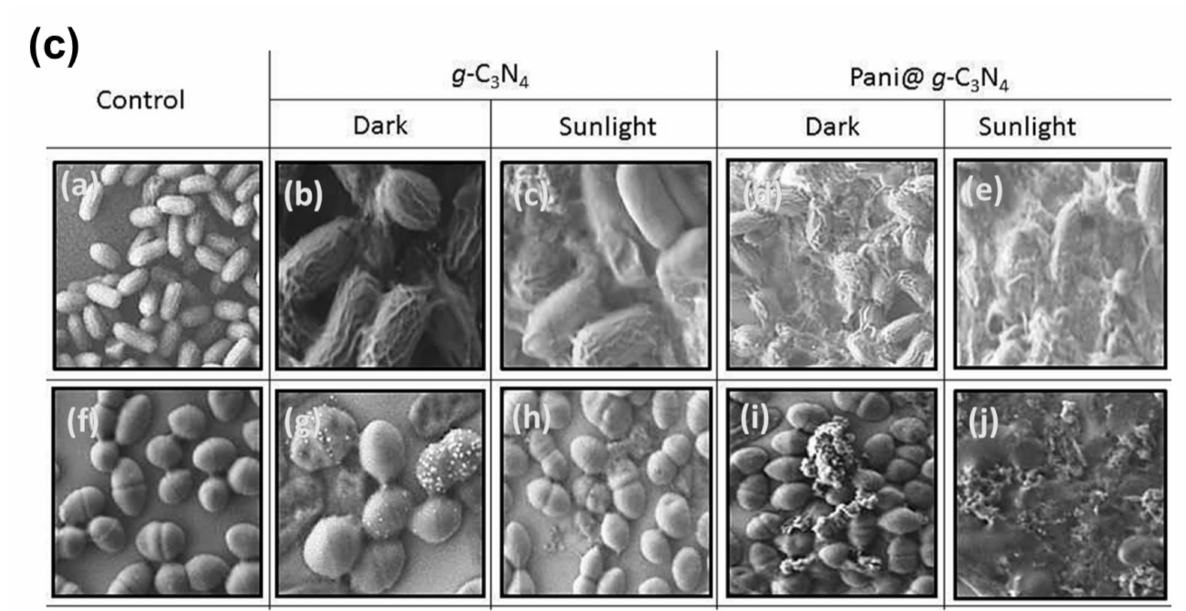
Figure 4. ( a ) 5 wt % content of PANI/Cu/TiO 2 nanocomposite and pristine PANI. ( b ) Antibacterial effect of a blank specimen, blank polyurethane coating (non-starred), and polyurethane coated with 5 wt%-PANI/Cu/TiO 2 content. (Reprinted from Ref. [82]). ( c ) The micrographs labeled (a) and (f) control E. coli and S. pneumonia , (b) and (g) are g-C 3 N 4 treated E. coli and S. pneumoniae in the dark, (c) and (h) are g-C 3 N 4 -treated E. coli and S. pneumoniae under sunlight (d) and (i) are PANI@g-C 3 N 4 - treated E. coli and S. pneumoniae in the dark while (e) and (j) are PANI@g-C 3 N 4 -treated E. coli and S. pneumoniae under sunlight, respectively. (Reprinted from Ref.